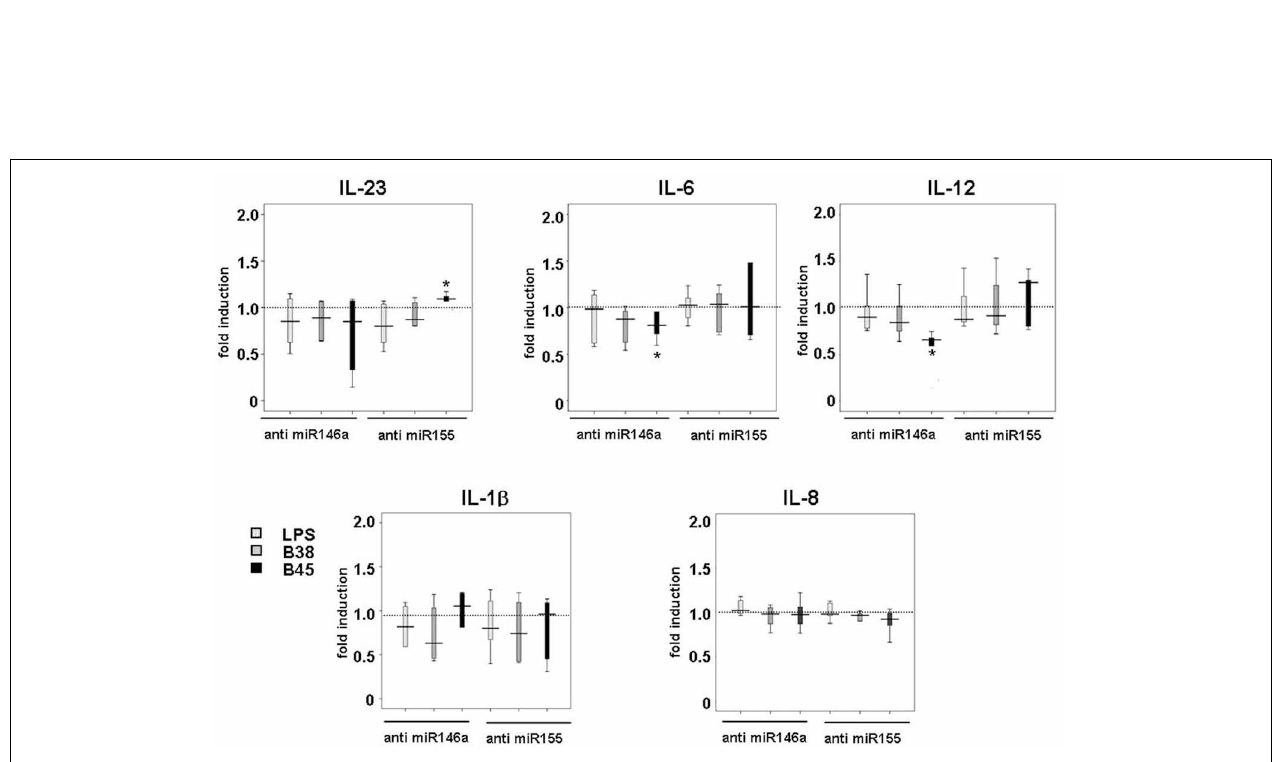
FIGURE A5 | Effect of miR-146a or miR-155 loss of function on H. pylori -induced IL-23, IL-6, IL-12, IL-1 β and IL-8 production. DCs were transfected with 100nM of miRNA-antisense (anti-miR-146a or anti-miR-155) or scrambled oligonucleotides before being challenged with B38 or B45 H. pylori strains at MOI 1 for 48h. IL-6 secretion was evaluated by flow